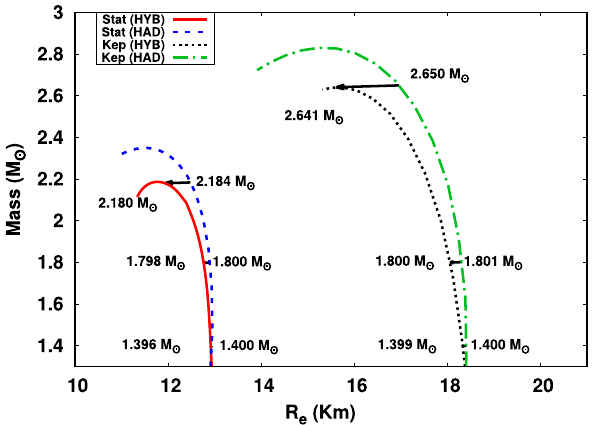
Fig. 7 Plot of gravitational mass as a function of the radius of the star. The Plot has been done for static and Keplerian stars constructed from S27 EoS. The Plot shows PT from NSs to HSs indicated by arrows (keeping the baryonic mass conserved). The mass and radius change can be seen from the plots where the mass loss is most prominent for the highest masses in each